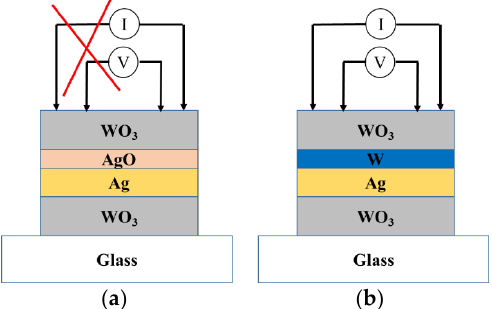
Figure 8. Schematic diagram of plating: ( a ) without barrier layer W on Ag film and ( b ) with W layer on Ag film.